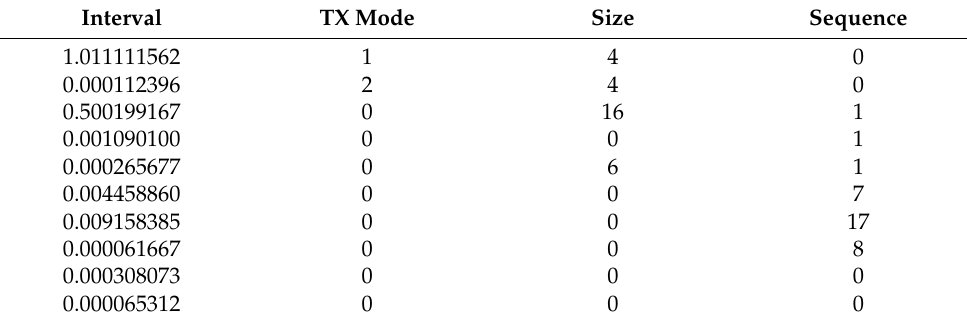
Figure 10. The result of data preprocessing for packet feature capture. Table 3. The packet features dataset. Table 3. The packet features dataset.